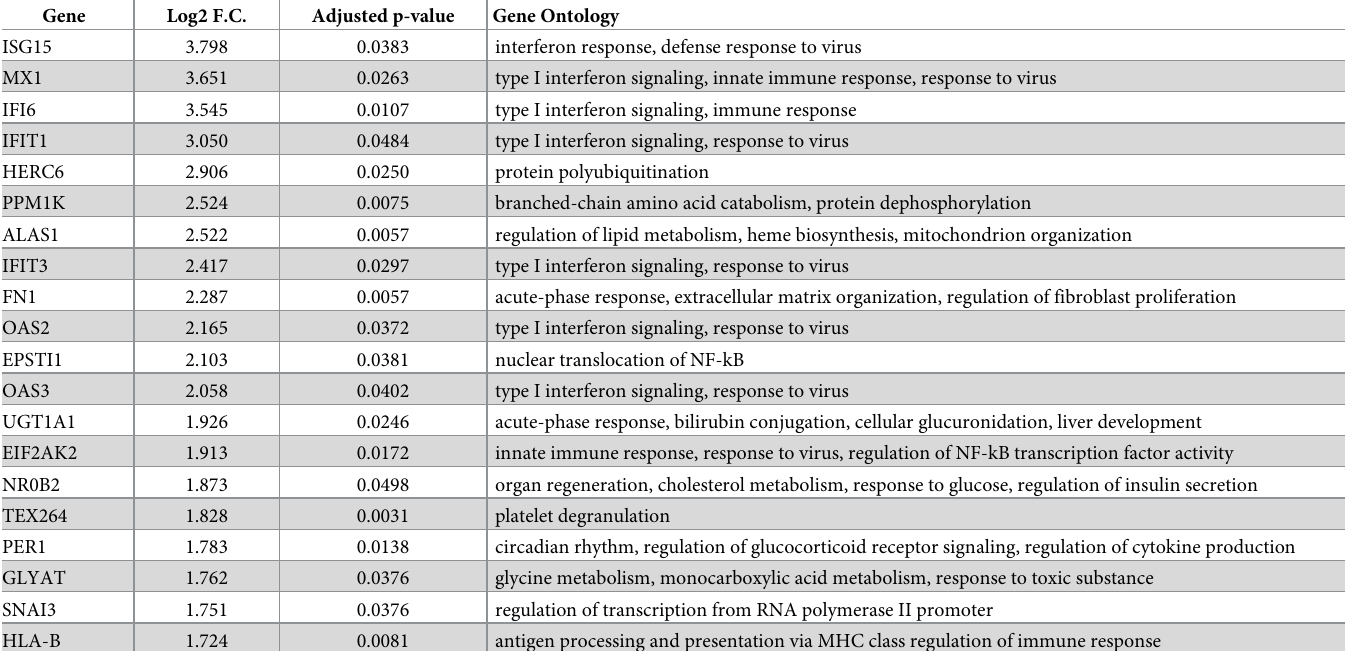
Table 1. Top differentially expressed genes in SIV+ adult macaques. Gene Log2 F.C.